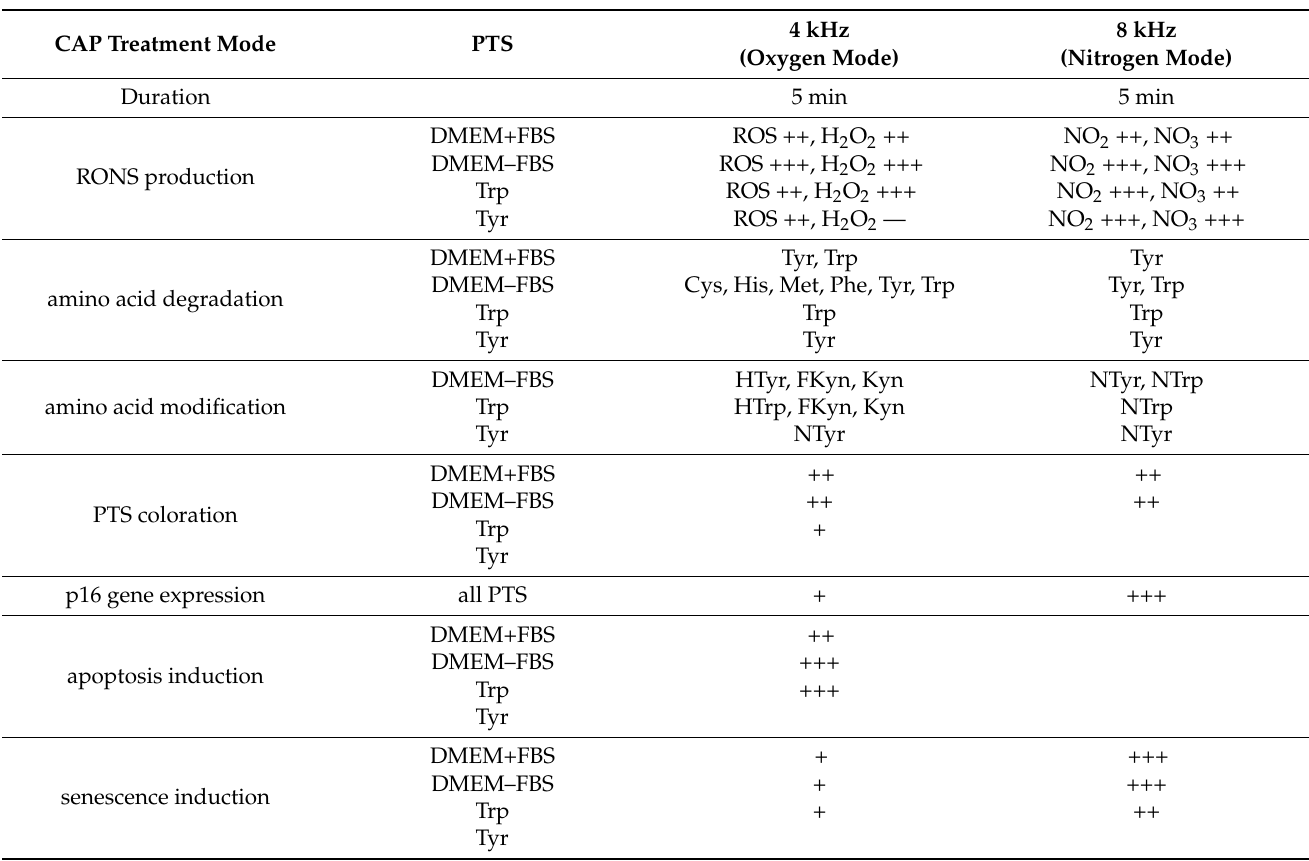
Table 2. Summary. Mode-dependent CAP effects on PTS and its influence on molecular- and cellular mechanisms in Mel Im melanoma